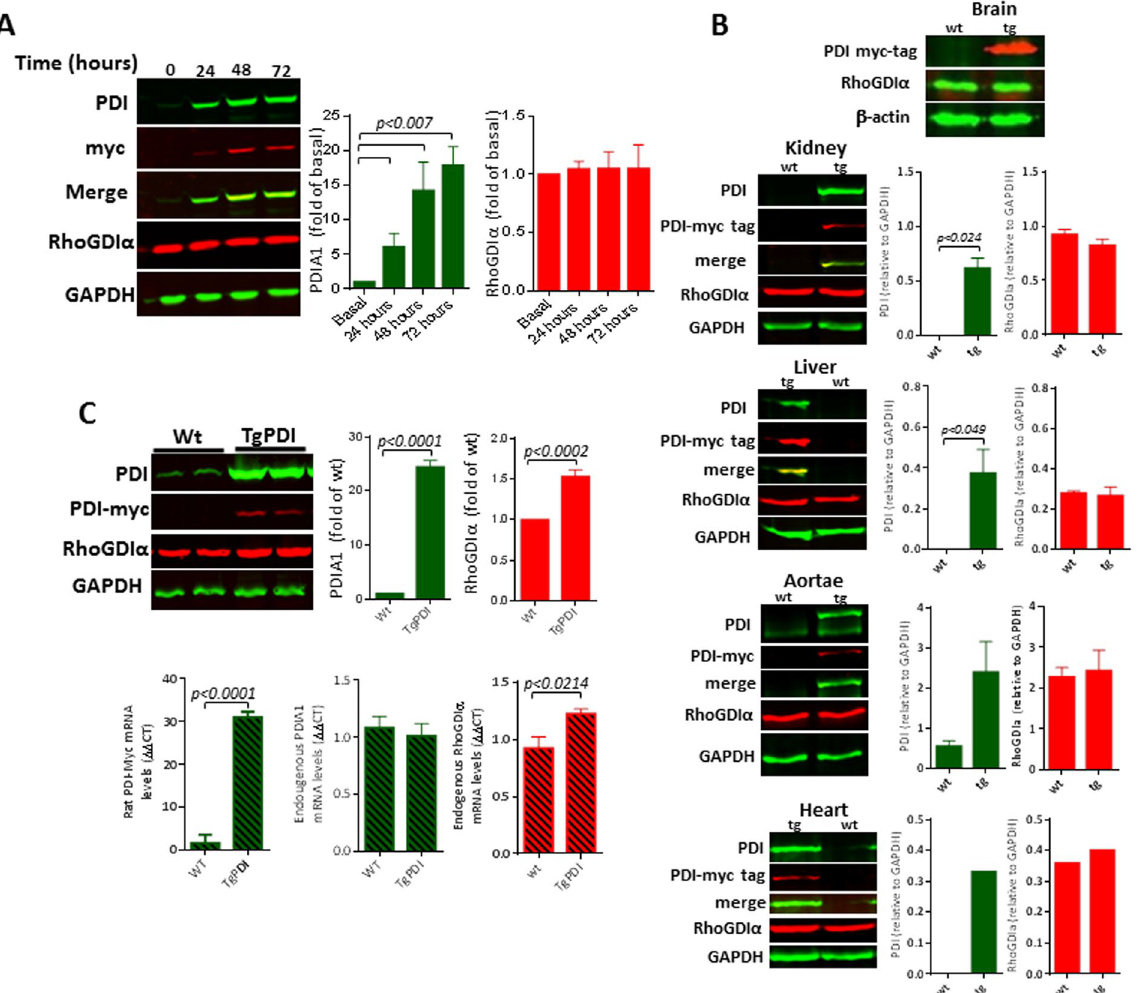
Figure 6. Investigation of PDIA1 and RhoGDI α co-regulation in different systems. ( A) RhoGDI α protein levels following PDIA1 overexpression in VSMC using a doxycyclin-inducible lentiviral vector carrying a myc-tag; ( B) Effects of PDIA1 overexpression upon RhoGDI α levels in a transgenic mouse model. Tissue from transgenic PDIA1-overexpressing mice: brain, kidney, liver, aortae and heart. Data representative of n ≥ 3, 2 (heart) or 1 (brain). ( C) RhoGDI α protein and mRNA levels in VSMC from transgenic PDIA1-overexpressing mice. Representative of 3 independent experiments. Uncropped western blots are shown in Supplementary Figs S8 and